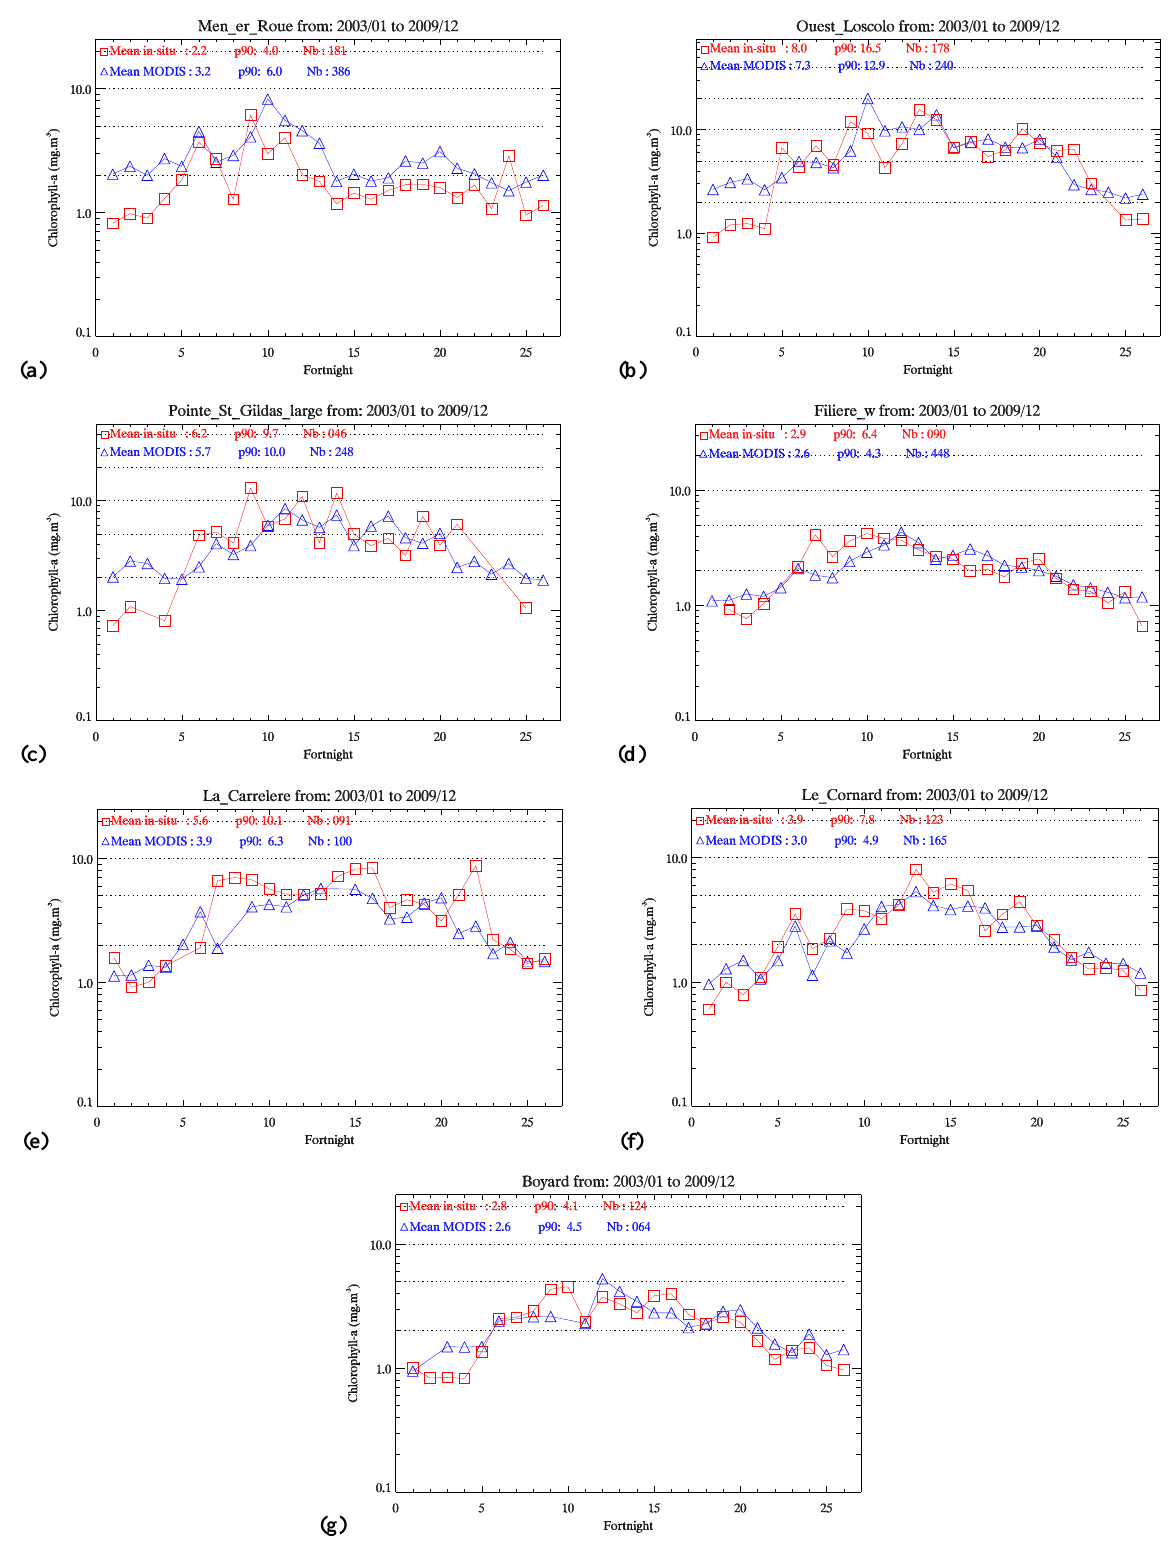
Fig. 4. The annual cycles of Chl at the selected stations of the Atlantic